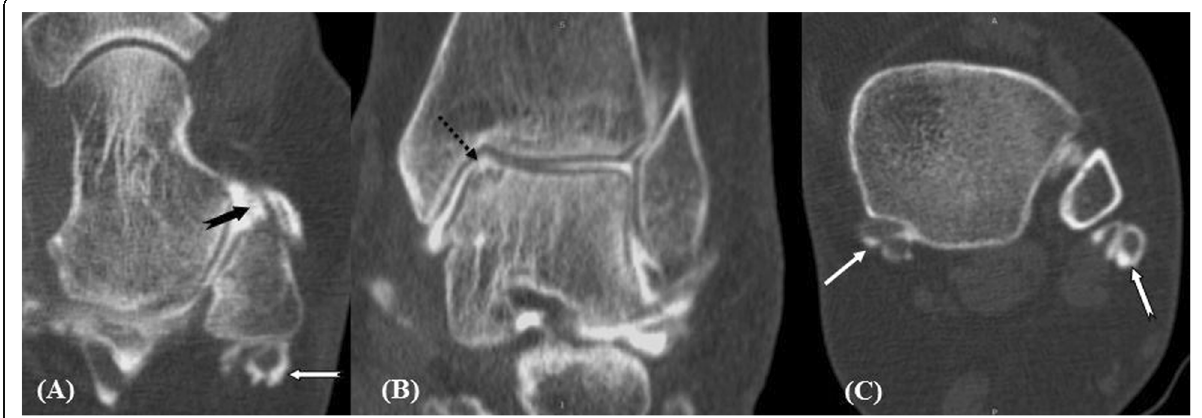
Fig. 6 Subacute recurrent diffuse left ankle pain following severe lateral ankle sprain. Axial CTA image through the talar neck ( a ) shows a complete tear of the superior band of ATFL (black arrow), and contrast entrance into the peroneal tendon sheath (white arrow) indicative for CFL tear. Coronal CTA ( b ) demonstrates medial talar dome type IIA OCL (dashed arrow). Axial CTA at the syndesmosis level ( c ) contrast passage into the tibialis posterior tendon sheath (white arrow) as well as the adjacent flexor digitorum longus tendon sheath denoting superficial deltoid tear through the MMFS